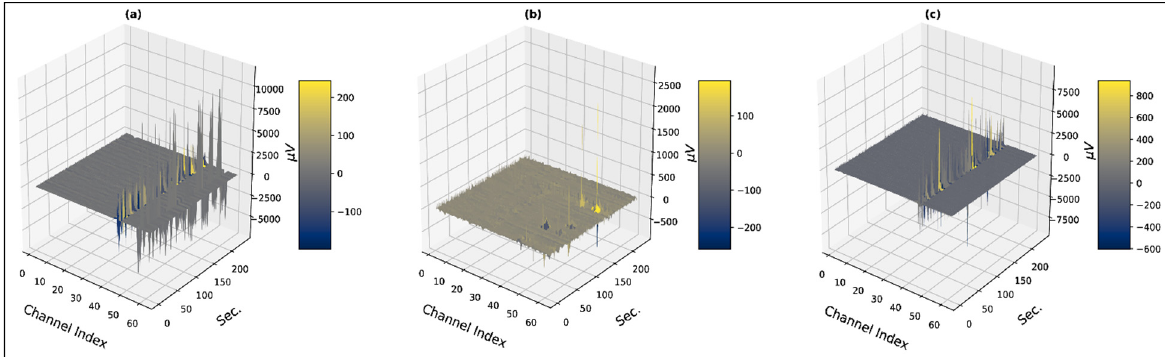
Figure 2. Three-dimensional visualization of faulty trials with overshooting/corrupted